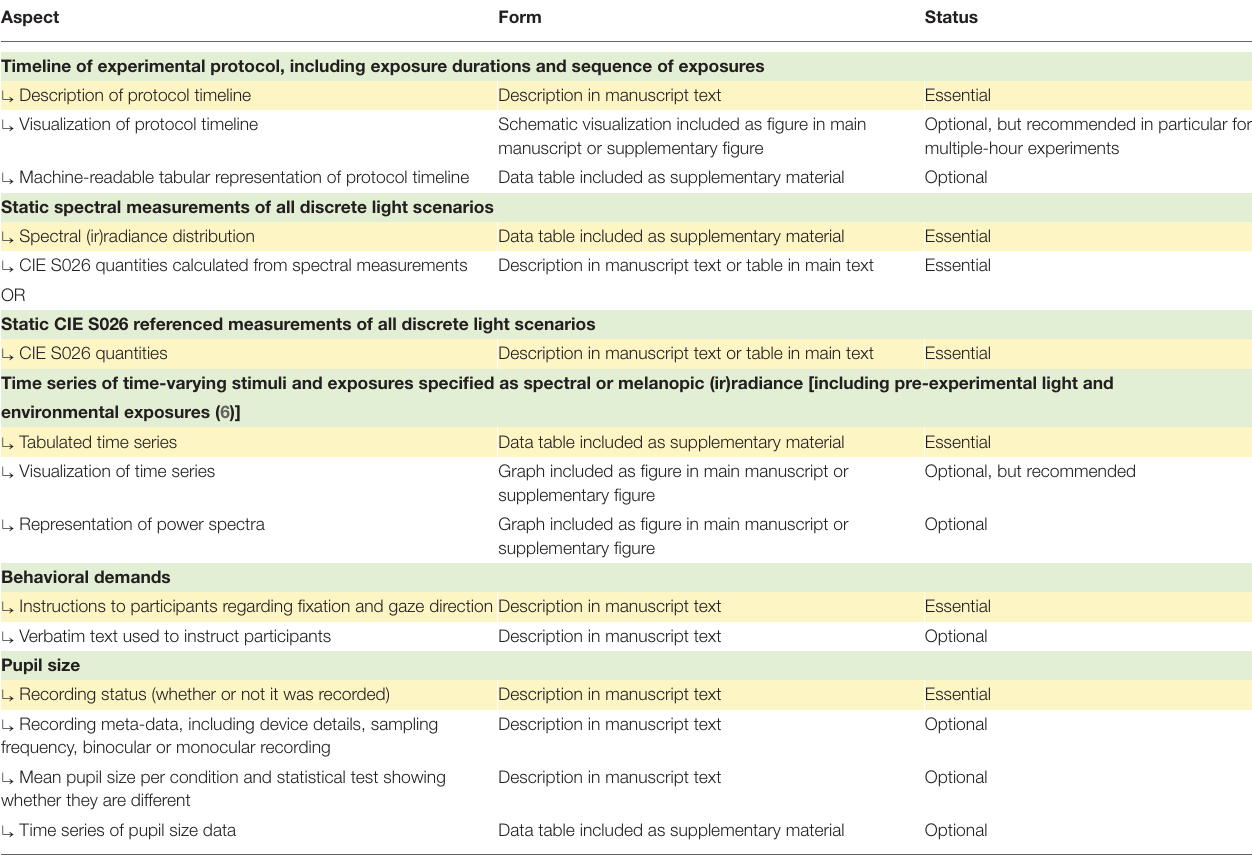
TABLE 1 | Recommended reporting of time-varying